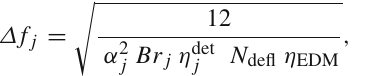
polarised along Oy axis (see Fig. 3 centre) and hence the root mean square of y -component of initial polarisation ξ rms